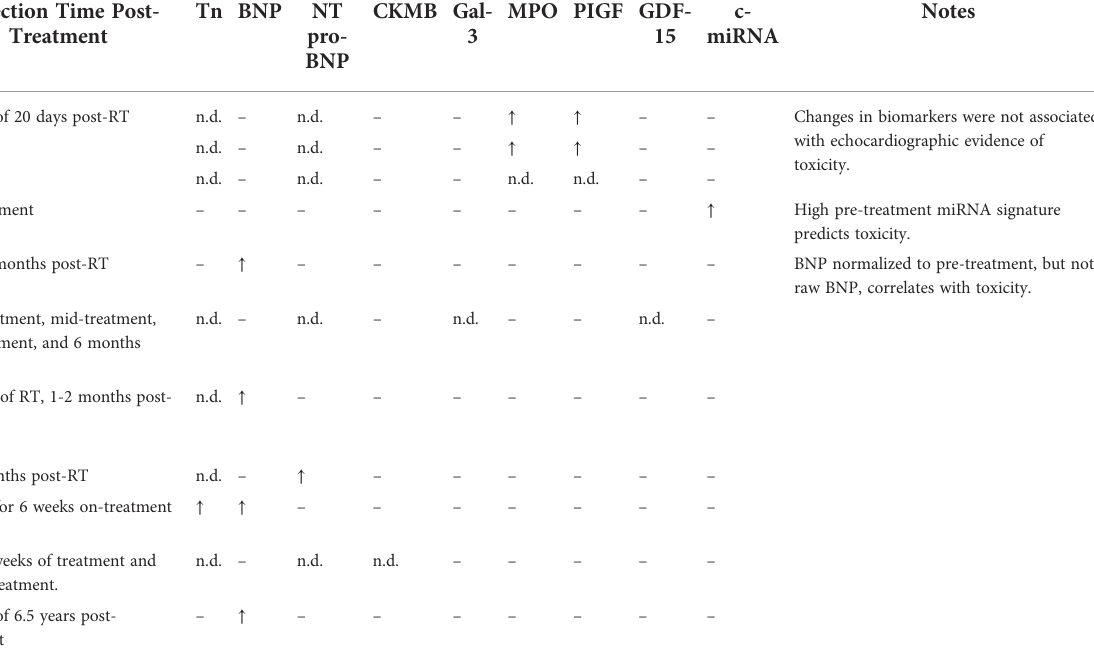
TABLE 1 Summary of biomarkers studied in radiation-induced heart disease in